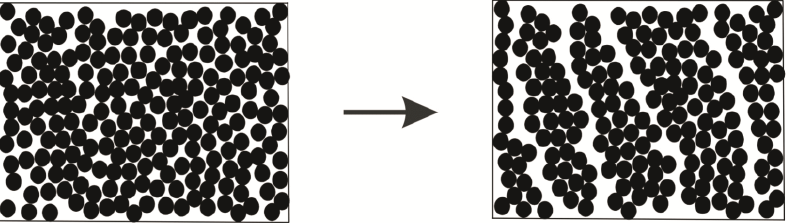
Figure 22. Formation of separate clusters of solid particles with their consequent